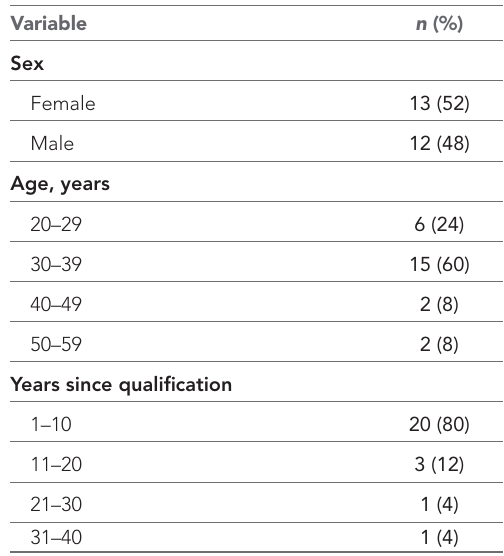
Table 1 Sociodemographic characteristics of the